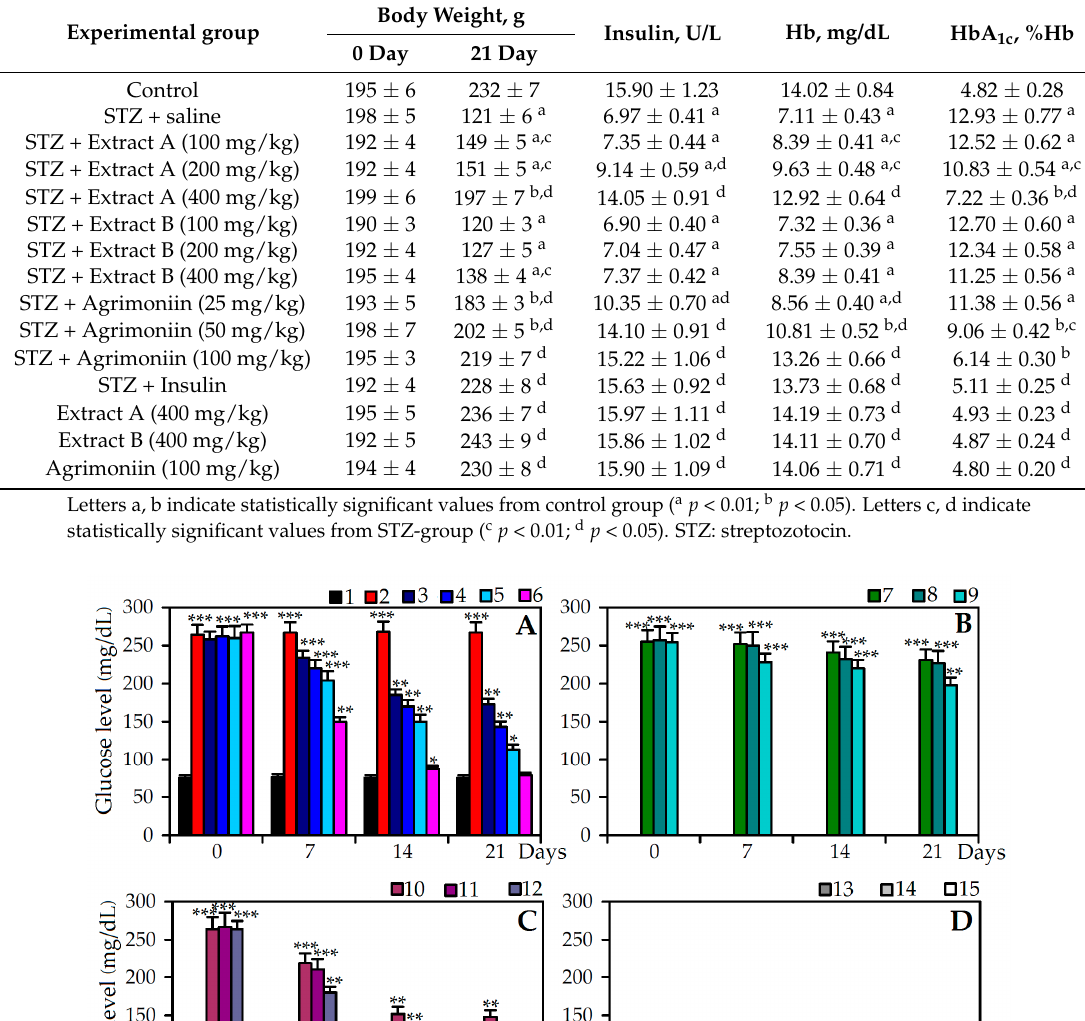
Table 4. Parameters of body weight, insulin, total hemoglobin (Hb) and glycosylated hemoglobin (HbA 1c ) of control and experimental groups, mean ± SD.